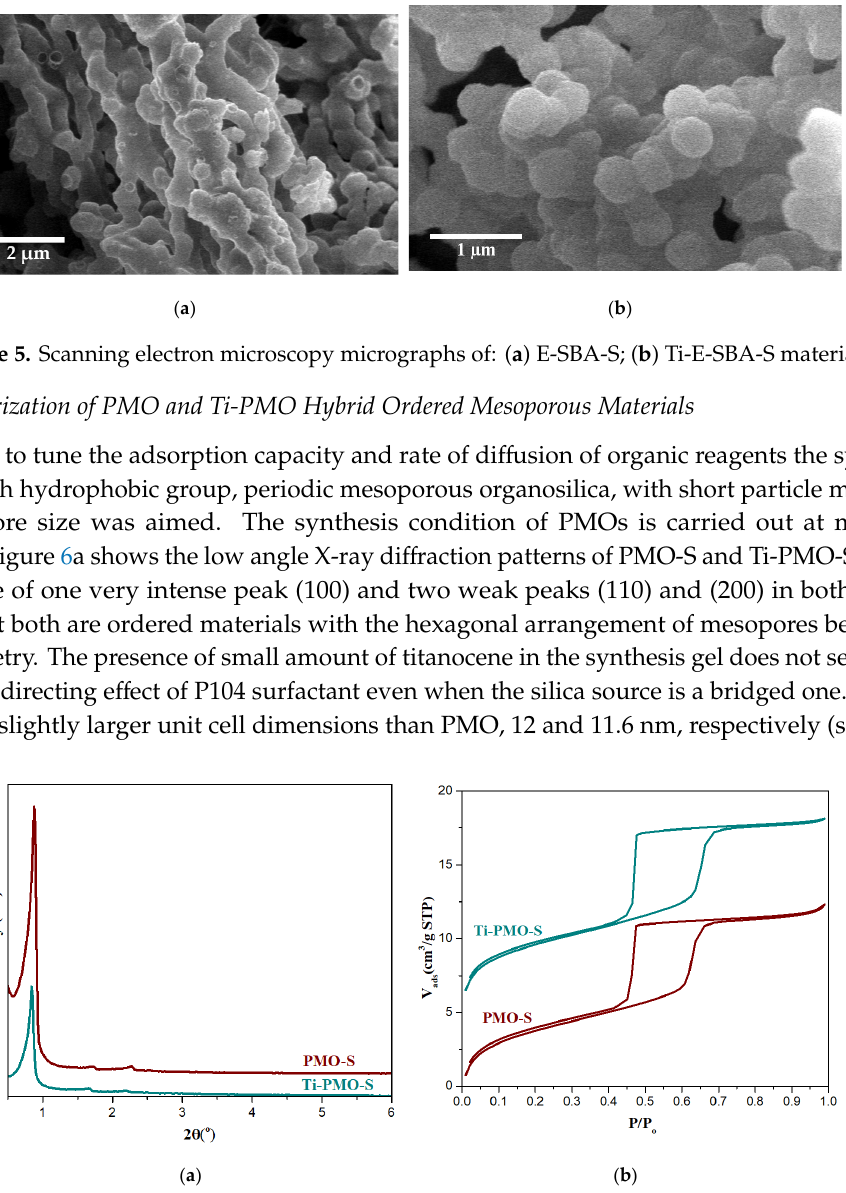
(b ) Figure 4. TEM images of: ( a ) E-SBA-S and (b) Ti-E-SBA-S materials.